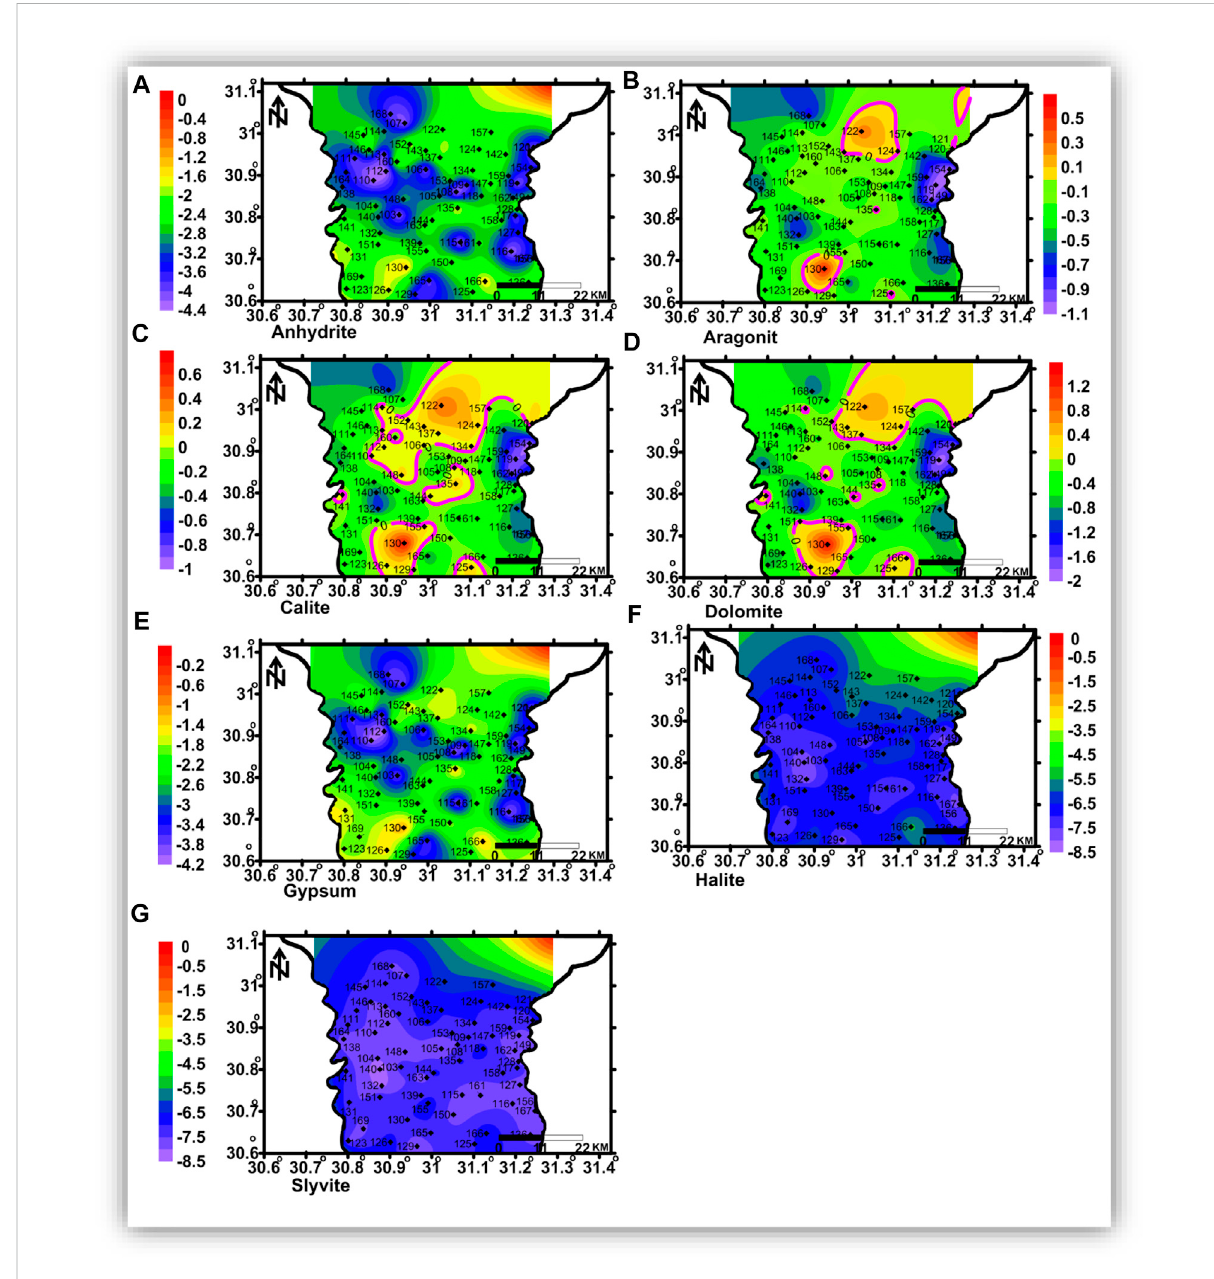
FIGURE 15 Spatial distribution maps of the dissolved minerals ’ saturation indices in the deep